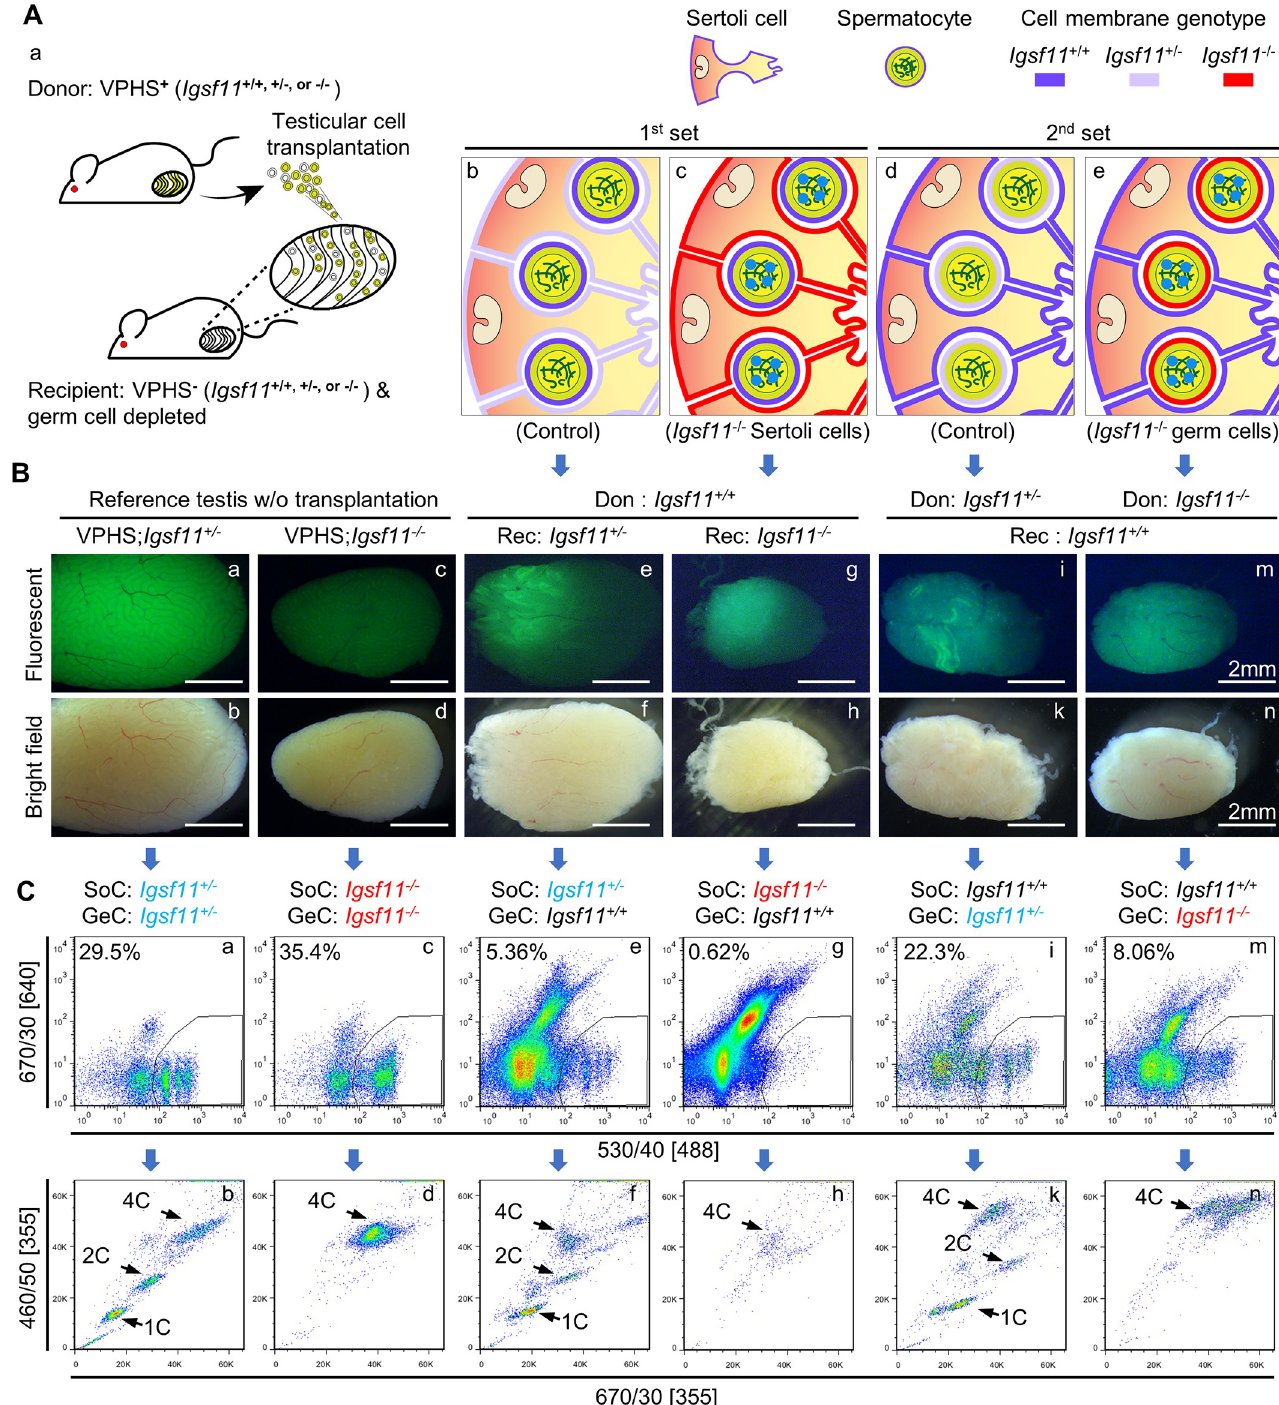
Fig 3. IGSF11 from Sertoli cells and spermatogenic cells are both required for the completion of meiosis. (A) Schematic views of two sets of testicular cell transplantation experiments. Genotypes of the cells were indicated by different colors of their cellular membrane: Igsf11 +/+ , dark purple; Igsf11 +/- , light purple; Igsf11 -/- , red. In first set of transplantation, VPHS; Igsf11 +/+ donor testicular cells were transplanted into the testis of Igsf11 +/- or Igsf11 -/- recipient mice. In the second set of transplantation, VPHS; Igsf11 +/- or VPHS; Igsf11 -/- donor testicular cells were transplanted into the testis of Igsf11 +/+ recipient mice. (B) Detection of VPHS fluorescence in the recipient testes 4 month after testicular cell transplantations. (C) FACS analysis of V&H assays using recipient testes 4 month after testicular cell transplantations. Different combinations of Sertoli cells and germ cells with different Igsf11 genotypes were indicated on the top of each lane. See S4C Fig for analysis flow; S4D Fig for gating of mVenus-positive cells; and S4E Fig for comparison between V&H assay versus traditional Hoehcst33342 staining assay. Abbreviations: Don, donor; Rec, recipient; SoC, Somatic cell; GeC, Germ cell.